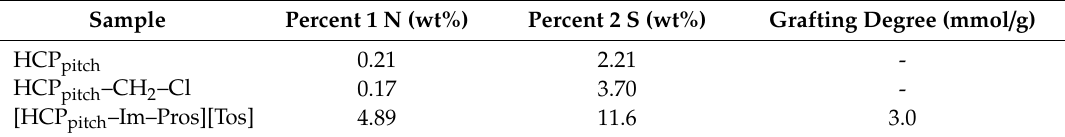
Table 1. Elemental analysis of HCP pitch , HCP pitch –CH 2 –Cl, and [HCP pitch –Im–Pros][Tos].